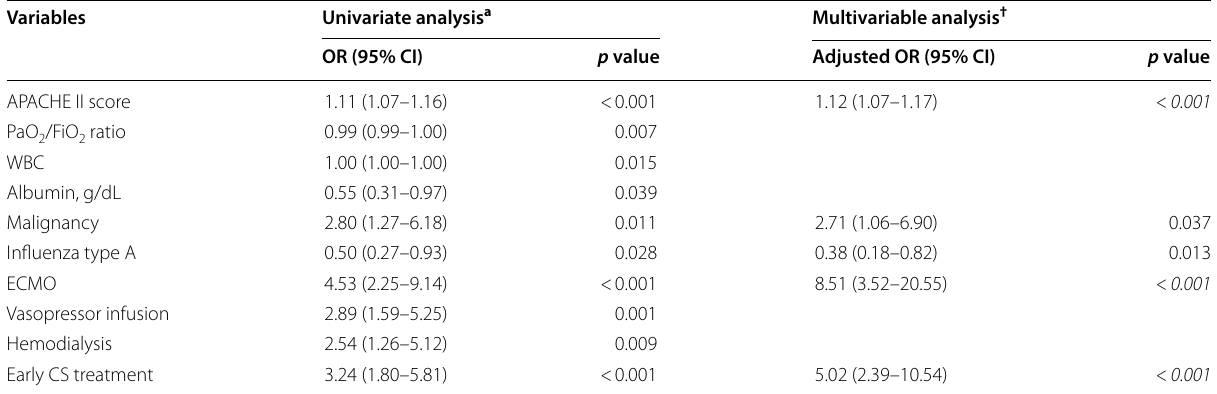
Table 2 Univariate and multivariable analyses of factors associated with hospital mortality in patients with influenza- associated